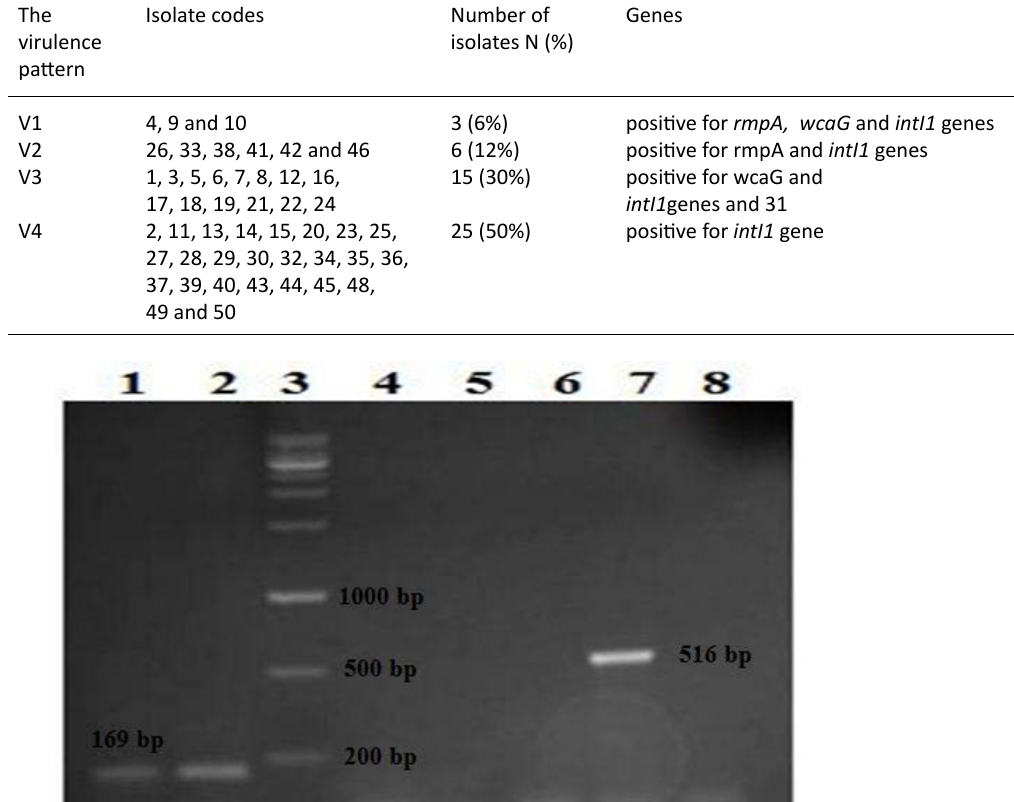
Fig. 2. Detection of the rmpA and wcaG genes on 1.5% agarose gel following amplification with PCR. Lanes 1 and 2: two isolates positive for the wcaG gene detected at 169 bp, lane 3: the DNA ladder, lanes 4, 5, 6, and 8: negative isolates and lane 7: one isolate positive for the rmpA gene detected at 516